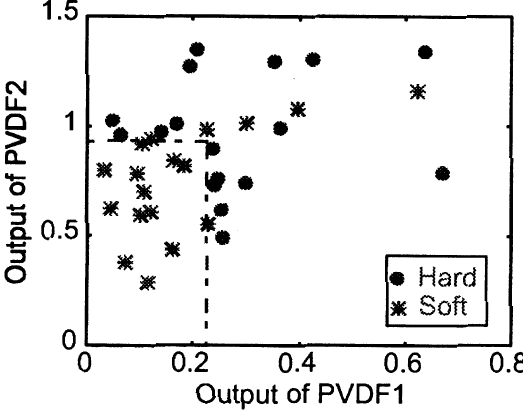
Fig. 17. Plot of indexes I 1 and I 2 calculated by eq.(16) (clinical test in rectal